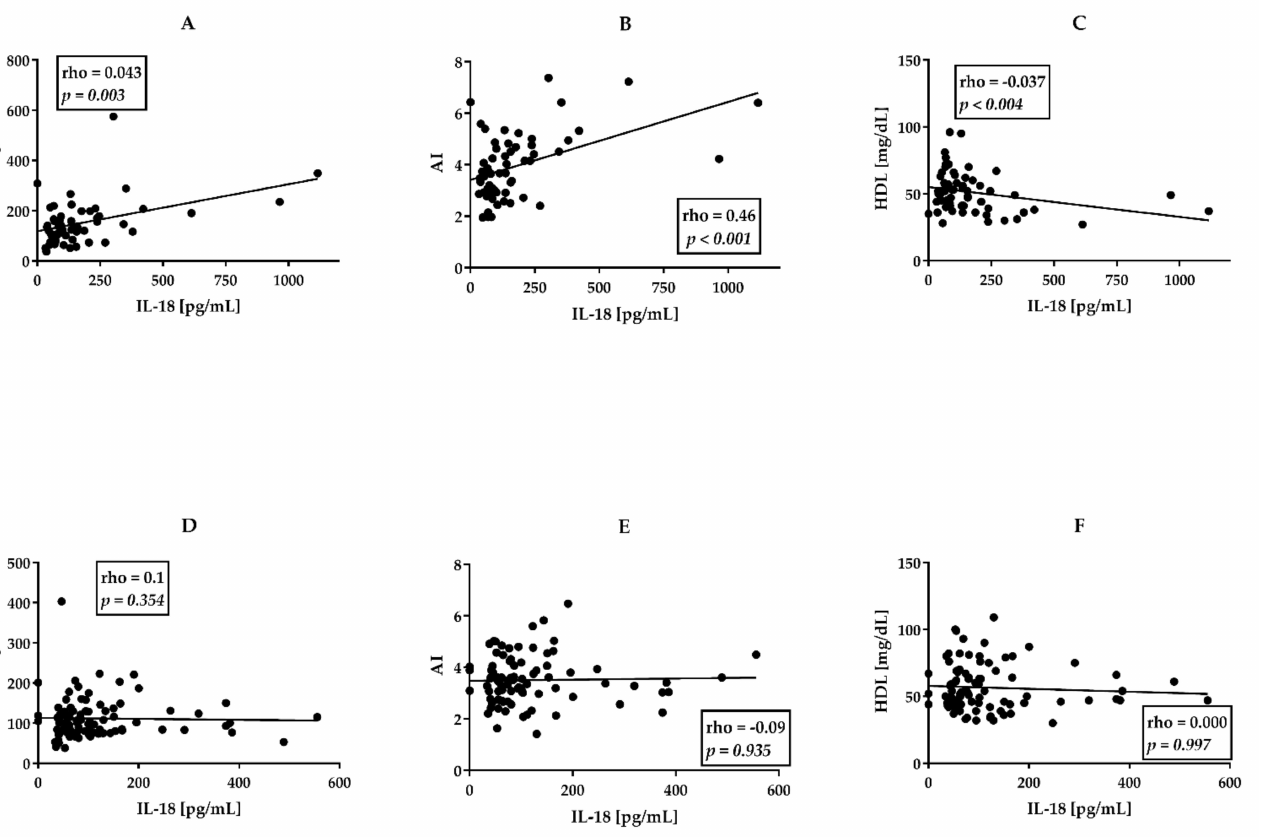
Figure 1. Correlations between IL-18 and lipid profile in patients with PsA (( A – C ), n = 61) in comparison with AS patients (( D – F ), n = 94). AI—atherogenic index. TG—triglycerides. HDL—High- Density Cholesterol. All correlations were analyzed using Spearman’s rank test. Rho—Spearman’s rank correlation coefficient. p —value for null hypothesis for Spearman’s rank